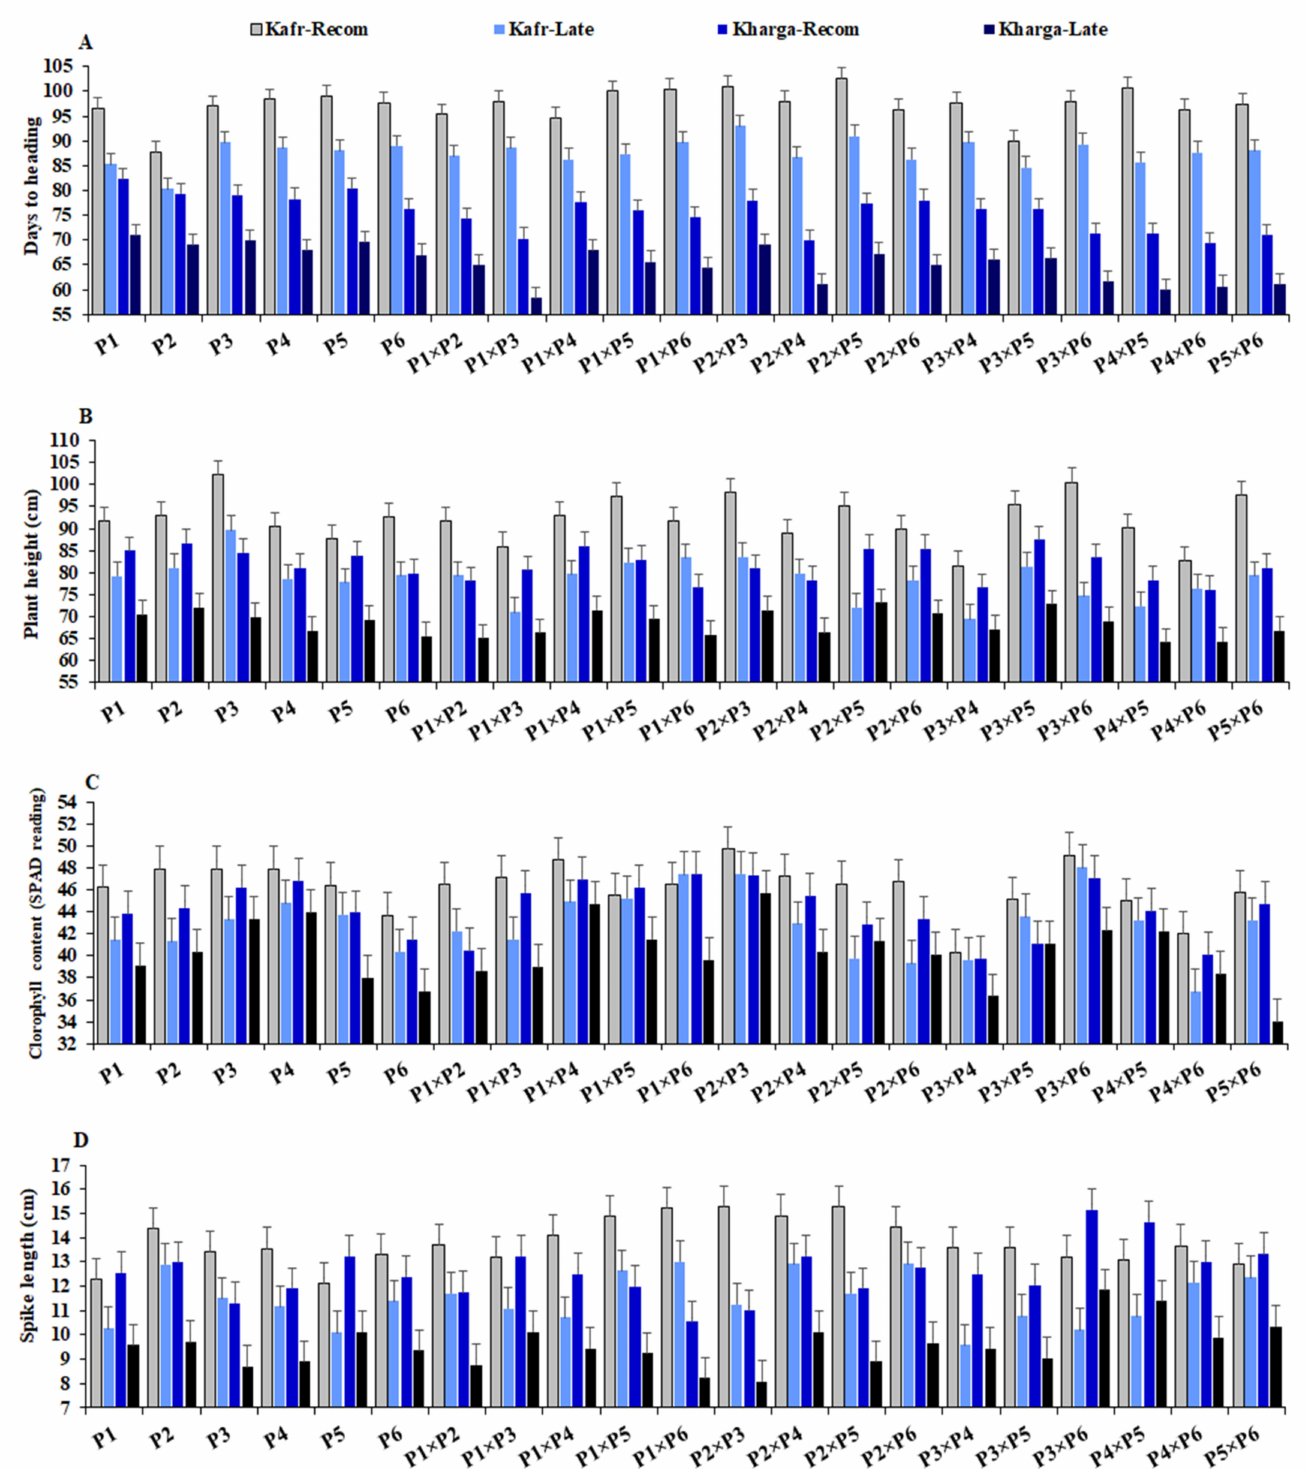
Figure 3. Mean performance of the 21 wheat genotypes for days to heading ( A ), plant height ( B ), chlorophyll content ( C ), and spike length ( D ). The bars on the top of the columns correspond to LSD ( p ≤